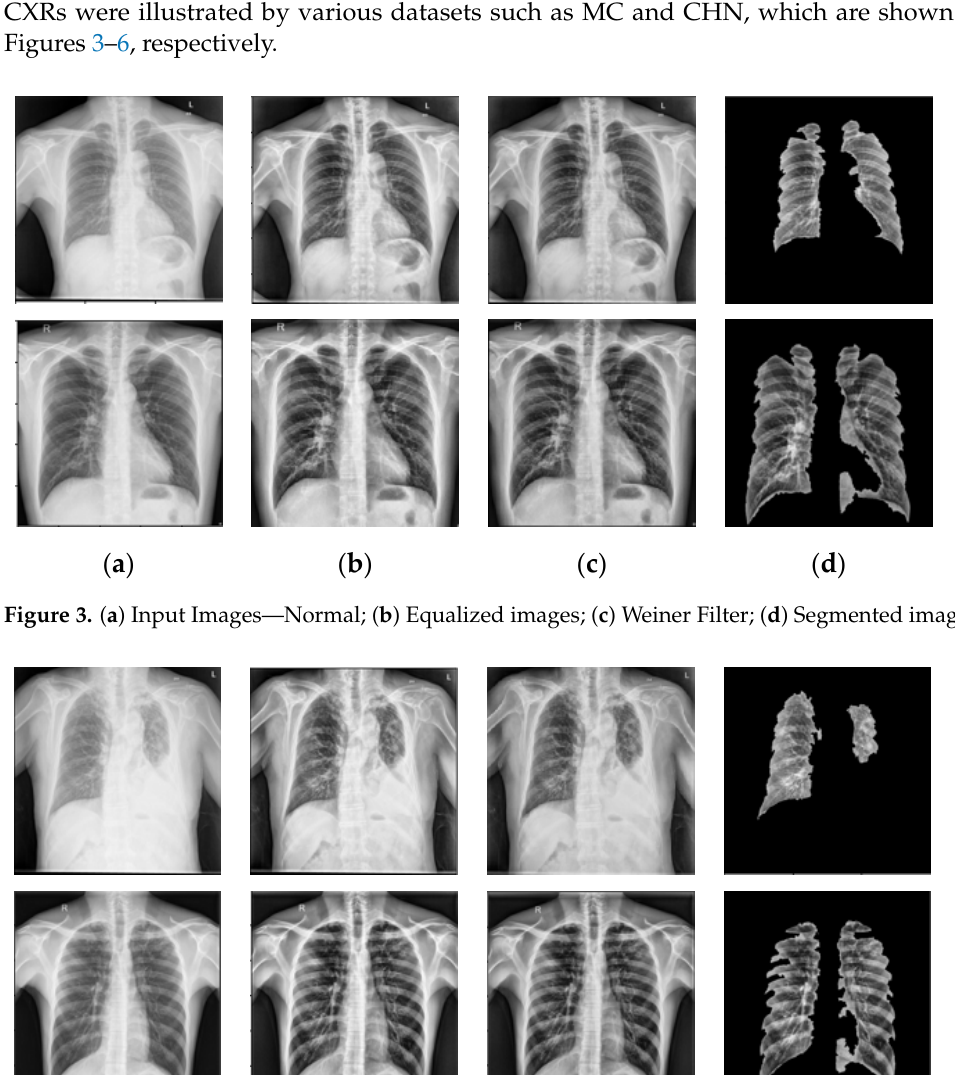
( d ) Figure 5. ( a ) Input Images—Normal; ( b ) Equalized images; ( c ) Weiner Filter; ( d ) Segmented images. In Figure 5, the first column (a) illustrates the input image, which is the normal CXR image; the second column (b) illustrates the output image, which was equalized from the given normal input image; the third column (c) illustrates the Weiner Filtered image of the given input image; and the fourth column (d) illustrates the output image, which was segmented using ROI-based morphological operations. These images were taken from the MC normal dataset. Figure 6 was processed and taken from abnormal images of the MC dataset.